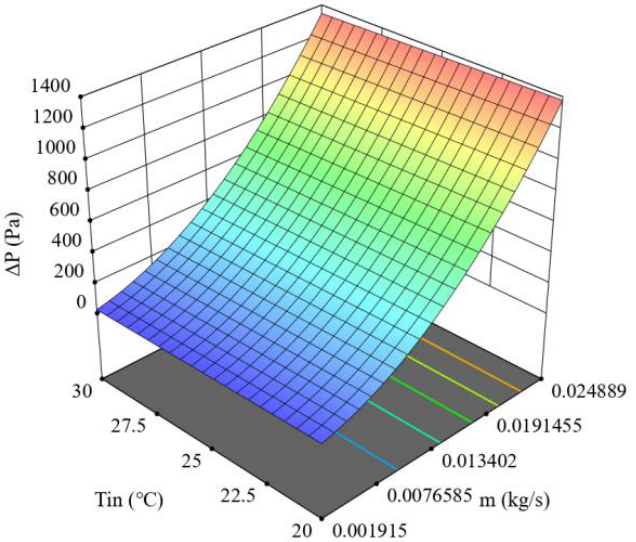
Figure 12. 3D surface plot of the combined effects of inlet temperature and flow rate on the pressure drop.